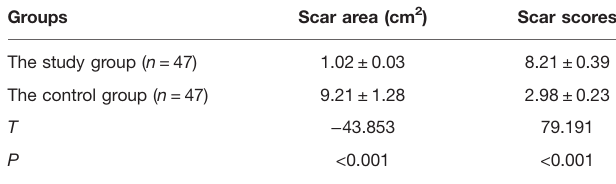
TABLE 4 | Comparison of incision healing between the two groups ( (cid:1) x + s).